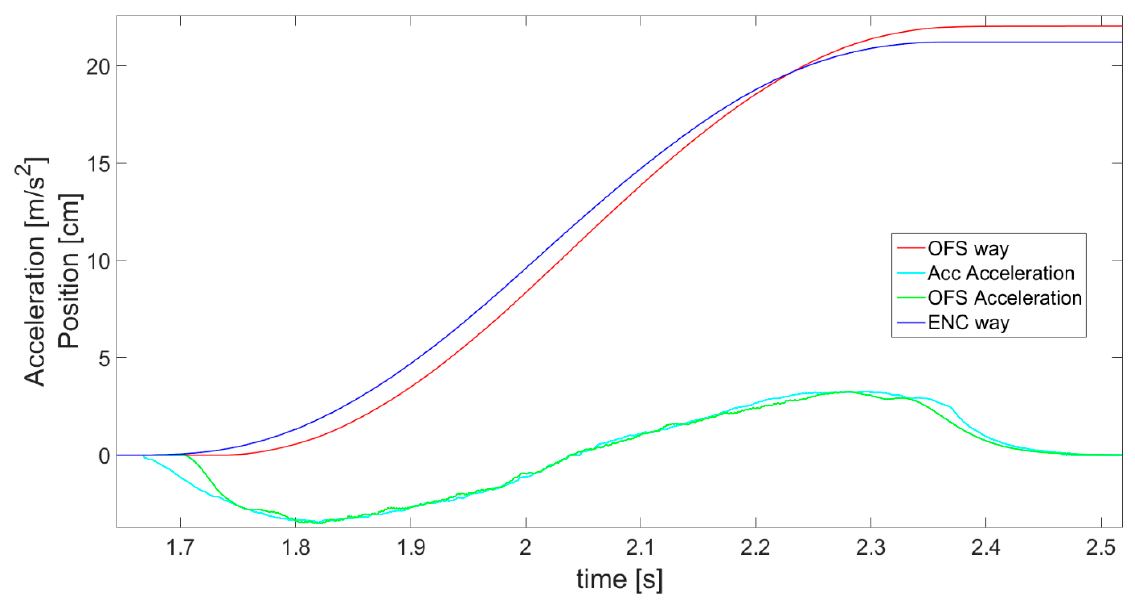
Figure 17. Magnification of part of Figure 16, showing complementary filter operation principles presented with acceler- ations of both sensors.